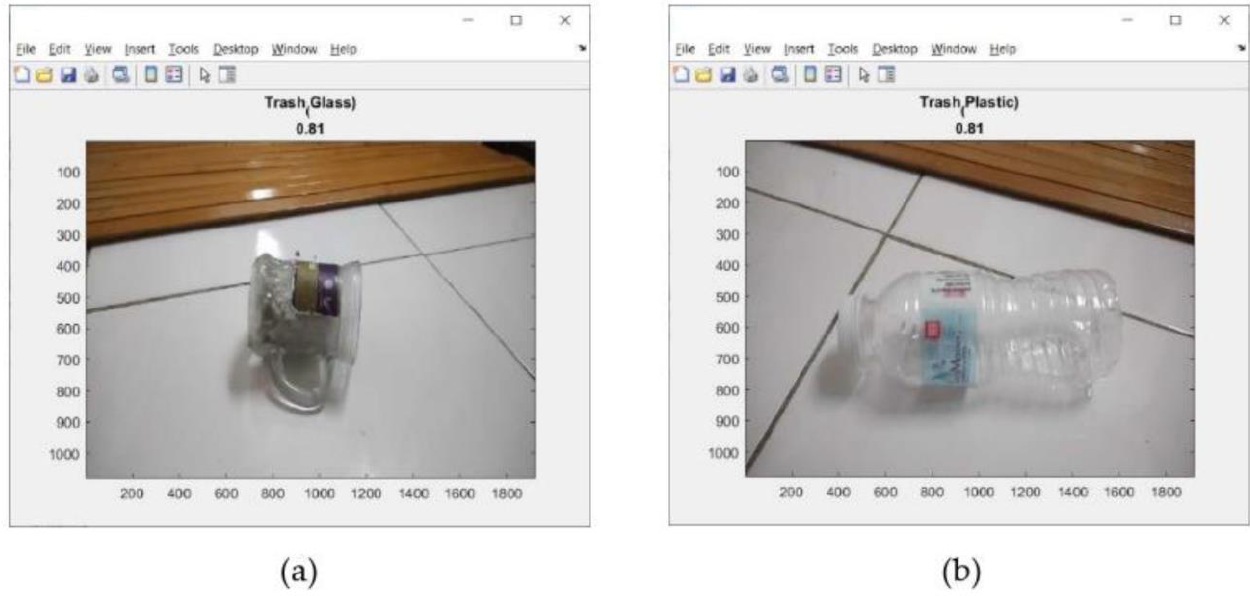
Figure 20. Results of trash identification using a real-time camera. ( a ) metal; ( b ) paper.